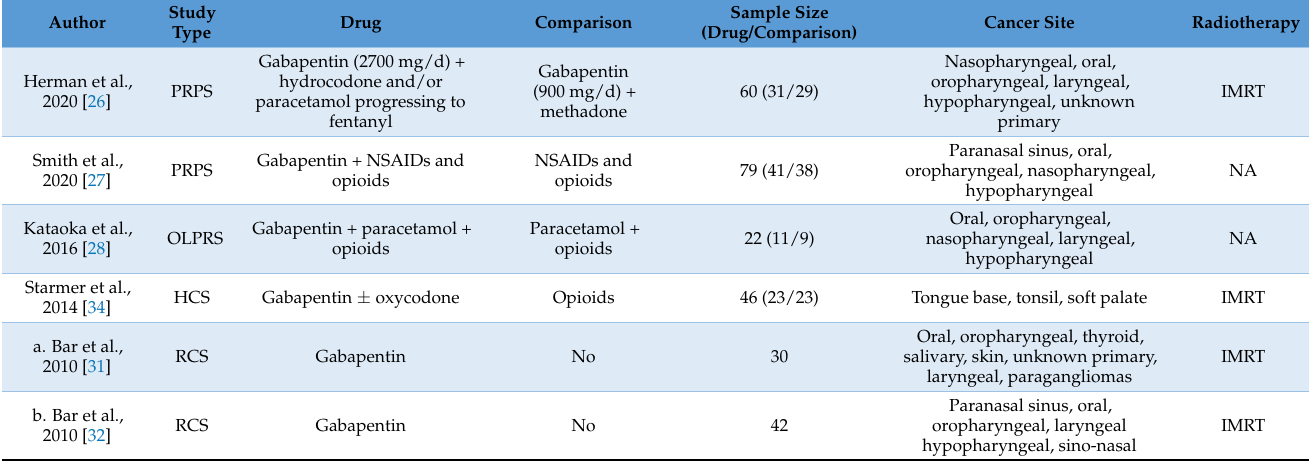
Table 1. Summary of the analyzed